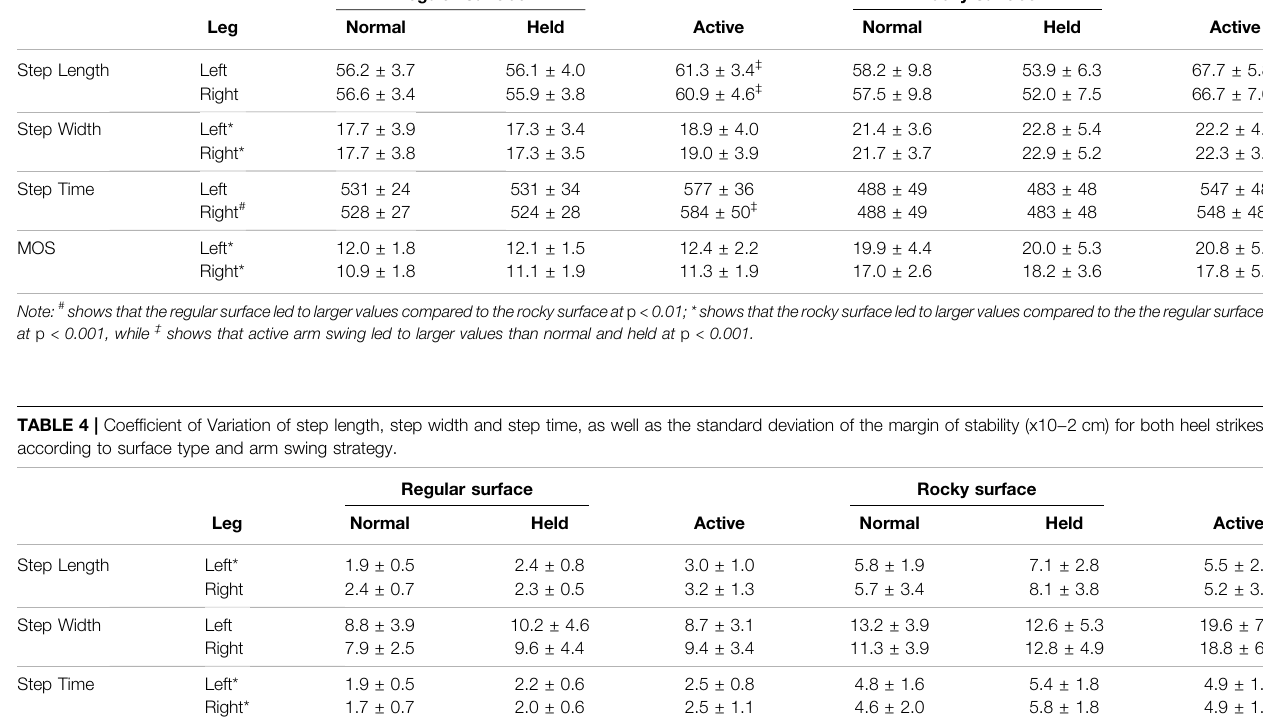
TABLE 3 | Average step length (cm), width (cm), time (ms) and margin of stability (cm) for both left and right heel strikes according to the surface and arm swing conditions. Regular surface